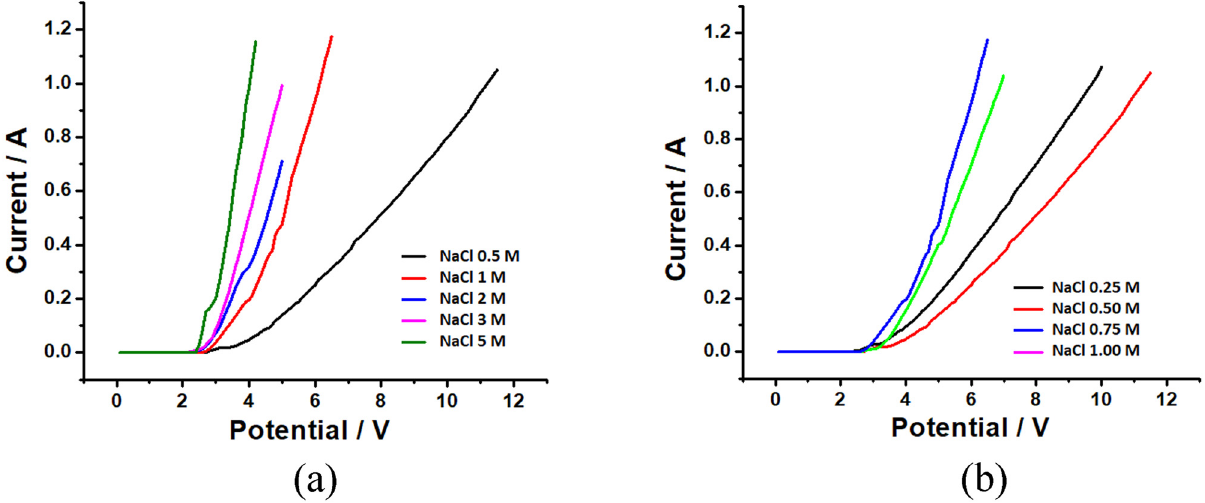
Figure 1: The current – voltage curve for electrolysis of ( a ) 0.5; 1; 2, 3 and 5 M Nacl and ( b ) 0.25; 0.50; 0.75 and 1.0 M NaCl concentration used for the NaOCl